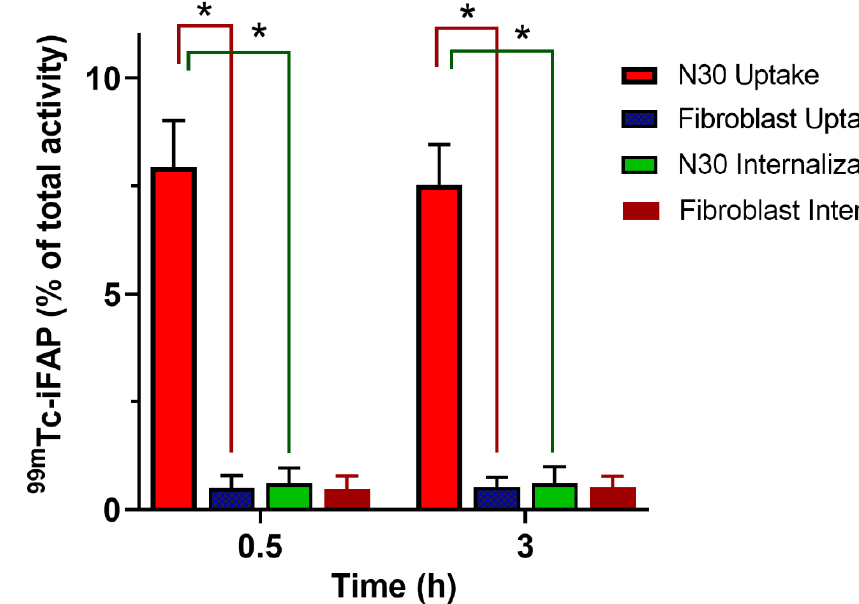
Figure 4. In vitro 99m Tc-iFAP uptake and internalization in N30 (primary human stromal endometrial cells, FAP positive) and by human fibroblasts (FAP negative control) ( n = 6). * Significant difference, p < 0.05; t -student.